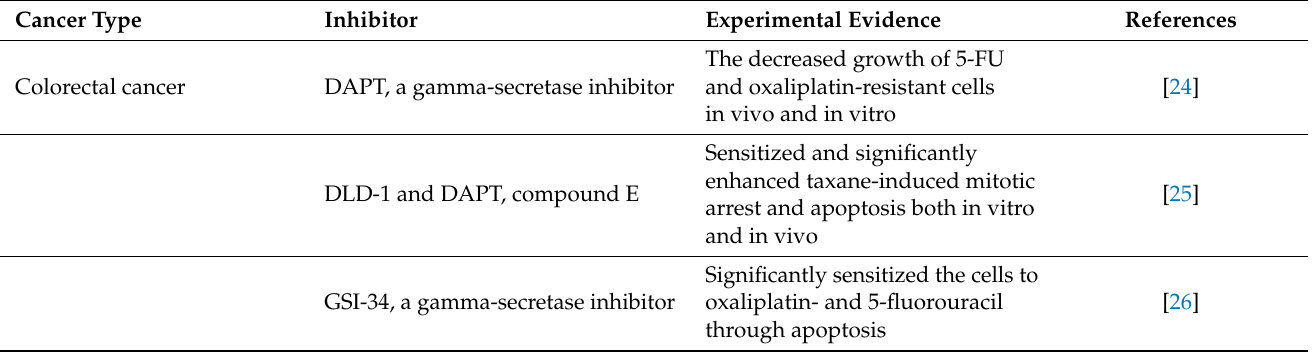
Table 1. Summary of evidence for the role of Notch signaling in chemoresistance of cancer stem cells. Cancer